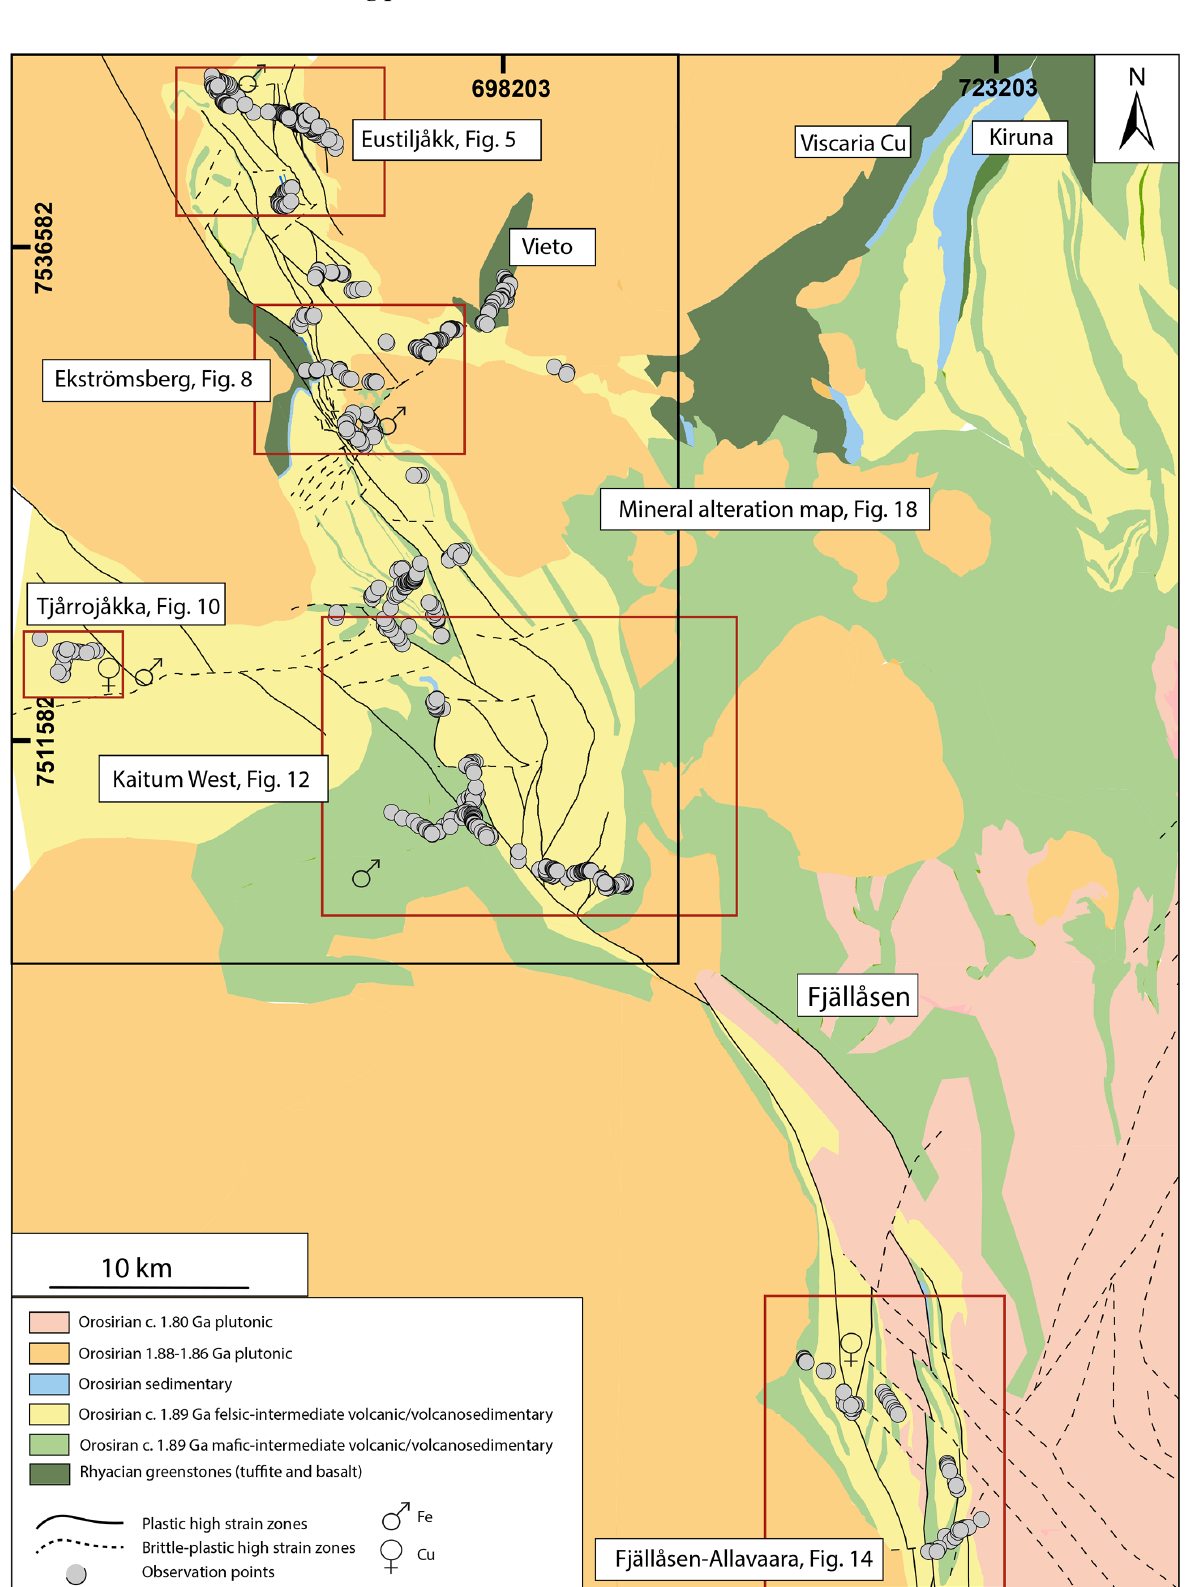
Figure 2. Geological map of the Western Supracrustal Belt showing the key areas mapped during this study. Lithological contacts simplified and modified after Offerberg (1967), Witschard (1975), and Bergman et al. (2001). Coordinates: